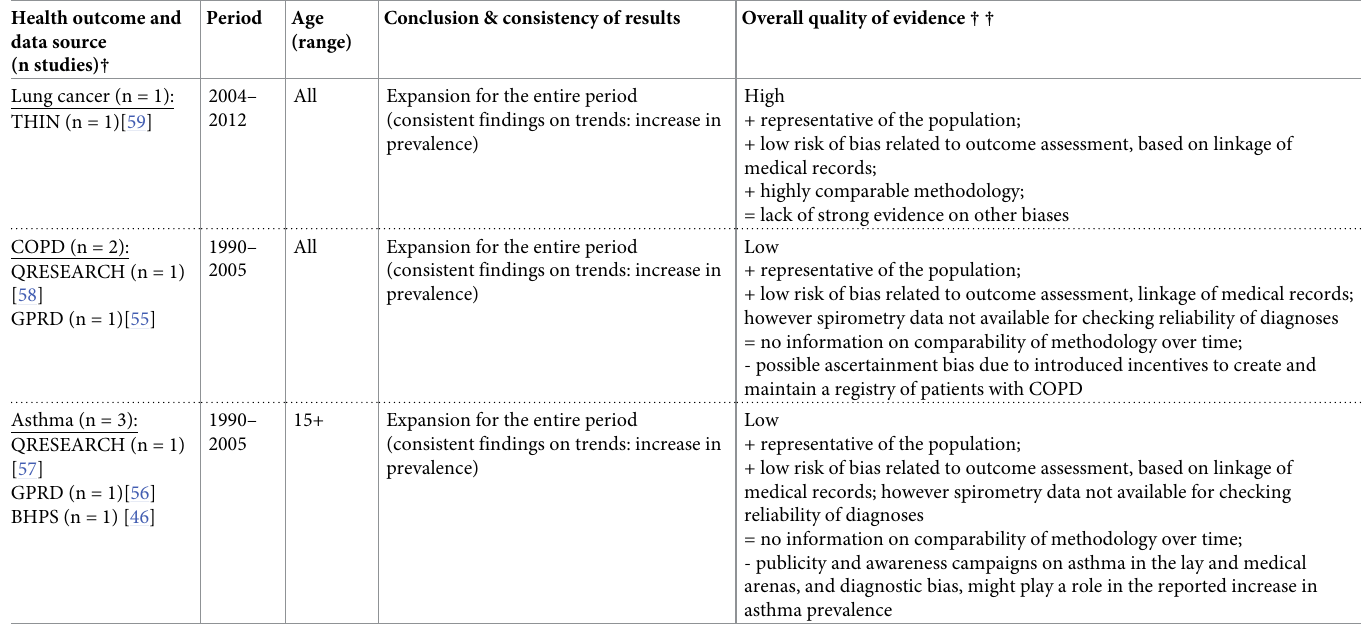
Table 4. The characteristics of evidence on prevalence of each health outcome, with the emphasis on size, consistency and quality (cont.). Health outcome and data